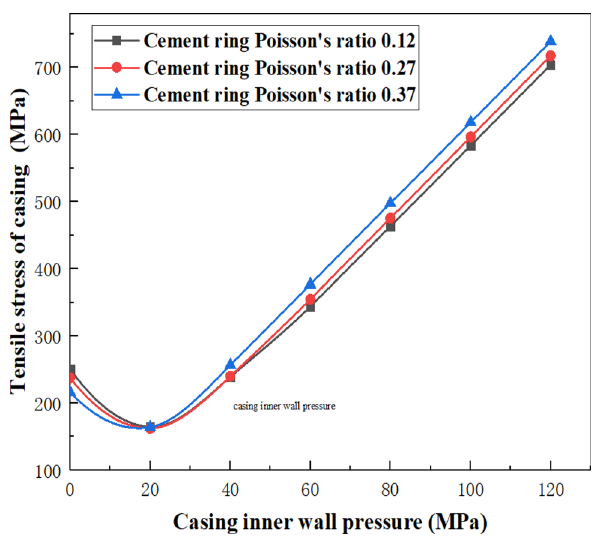
Fig. 12 Variation curve of casing tensile stress with casing inner wall